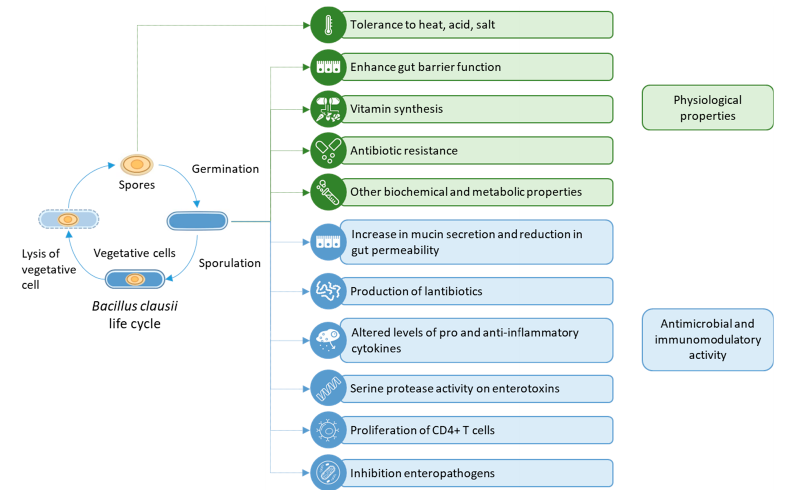
Figure 1. A summary of the physiological, antimicrobial, and immunomodulatory properties of Bacillus clausii .